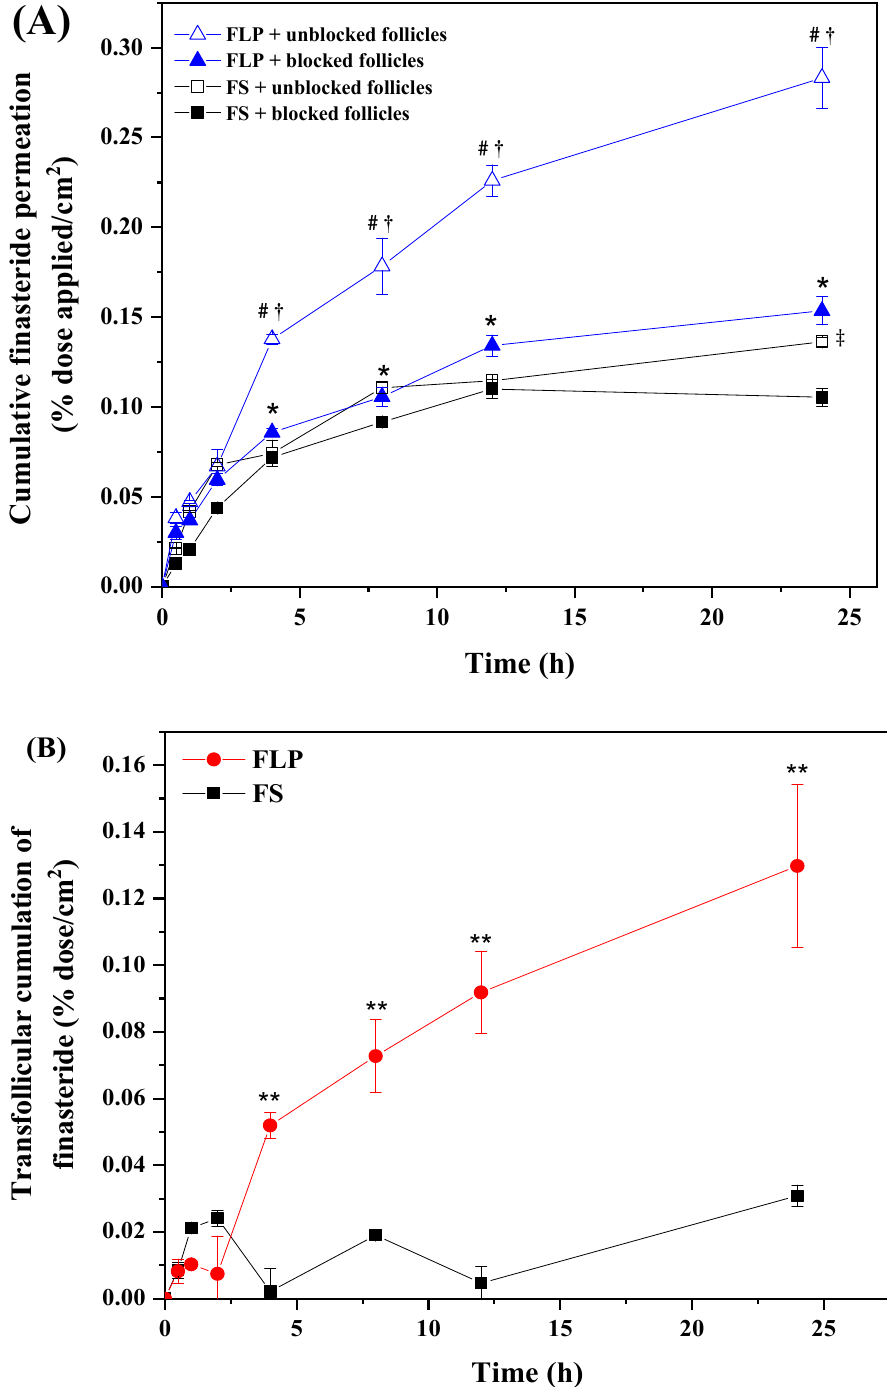
Figure 5. The cumulative amounts of FN in porcine skin by follicular closing technique ( A ) and calculated transfollicular accumulation ( B ). # p < 0.05 compared between FLP and FS unblocked follicles’ cumulation; † p < 0.05 compared between unblocked and blocked follicles’ cumulation of FLP; * p < 0.05 compared between FLP and FS blocked follicles’ cumulation; ‡ p < 0.05 compared between unblocked and blocked follicles’ cumulation of FS; ** p < 0.05 compared between FLP’s and FS’s cumulation.